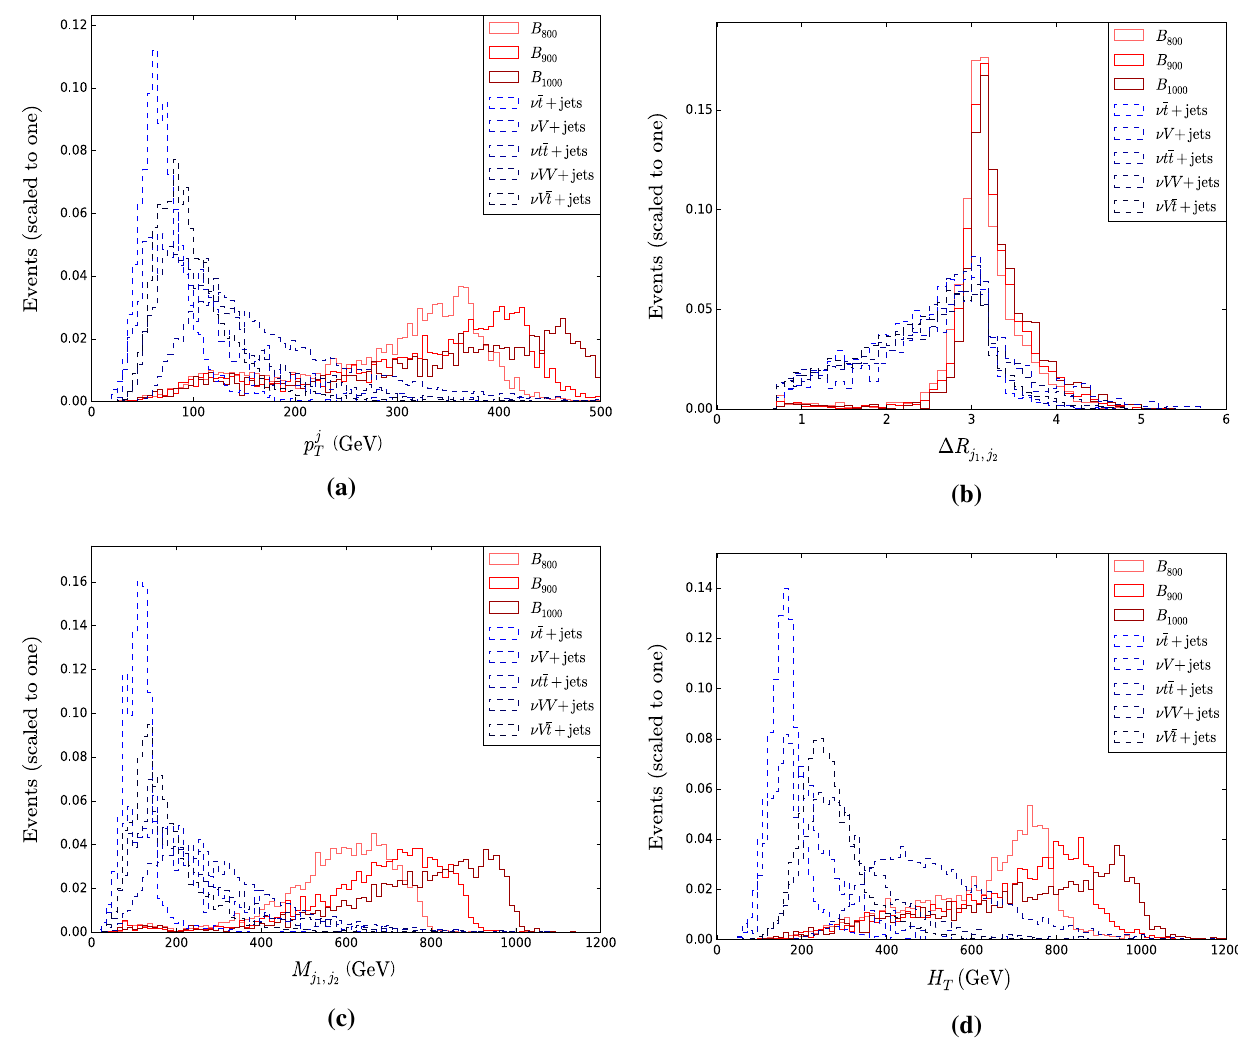
√ s = 1 . 98 TeV) with the integrated